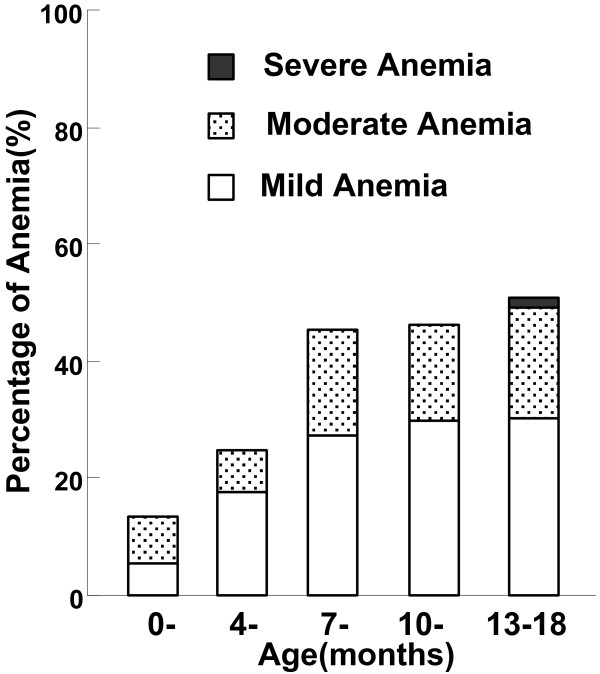
Percentage of anemia* in 0–18 month-old infants by age group in rural Shaanxi province, China, 2010. *Anemia: Hb level is below 145 g/L for infants aged 0–29 days, below 90 g/L for infants aged 30–119 days, below 100 g/L for infants aged 120–179 days, and below 110 g/L for infants aged 180 days to 18 months. Mild anemia: Hb level is between 90–144 g/L for infants aged 0–29 days, between 90–99 g/L for infants aged 120–179 days, between 90–109 g/L for infants aged 180 days to 18 months; Moderate anemia: Hb level is between 60–89 g/L for all age group infants; Severe anemia: Hb level is between 30–59 g/L for all age group infants.